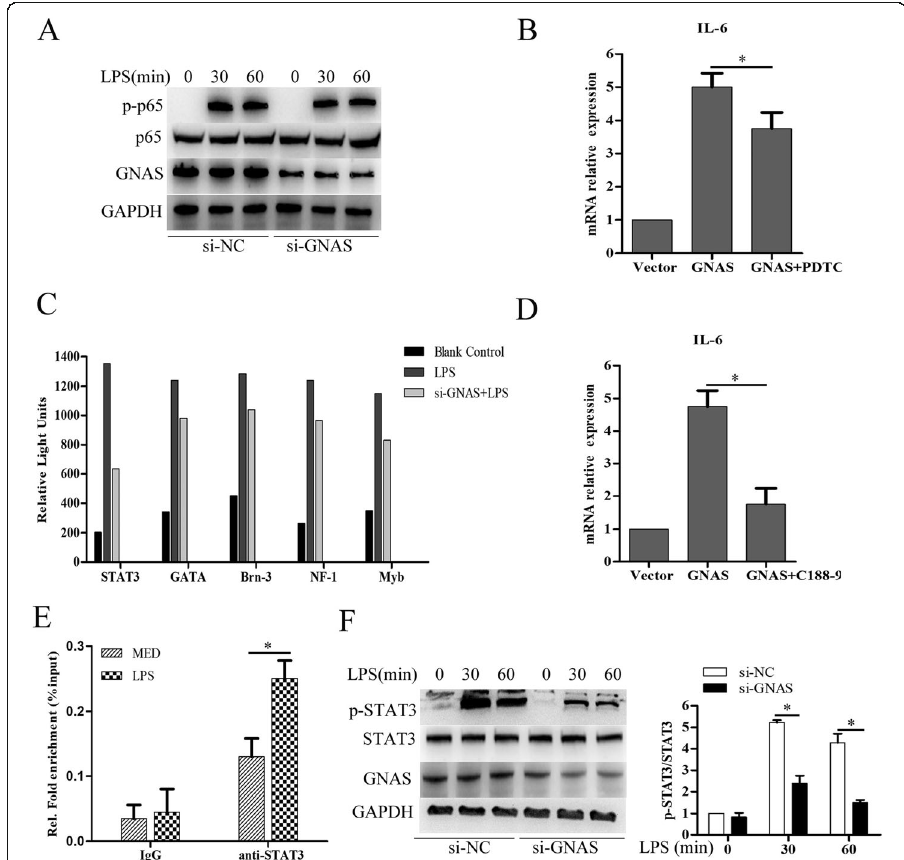
Fig. 3 GNAS knockdown inhibits LPS-induced IL-6 expression by suppressing STAT3 activation in HCC cells. a HepG2 cells were transfected with si-NC or si-GNAS for 24 h and then treated with LPS (5 μ g/ml) or not for the indicated hours. Then, the protein expression levels of p65, phosphorylated p65 (p-p65), and GNAS were detected by Western blotting. b HepG2 cells were transfected with pCMV-myc vector or pCMV-myc- GNAS for 24 h, and then treated with the specific inhibitor of NF-kB, PDTC, for 30 min. IL-6 mRNA expression levels were detected by qRT-PCR. c HepG2 cells were transfected with si-NC or si-GNAS for 24 h and then treated with LPS or MED for 30 min. Transcription factors activation profiling plate array was performed. d HepG2 cells were transfected with pCMV-myc vector or pCMV-myc-GNAS for 24 h, and then treated with a specific inhibitor of STAT3, c188 – 9, for 30 min. IL-6 mRNA expression levels were detected by qRT-PCR. e HepG2 cells were transfected with si-NC or si-GNAS for 24 h and then treated with LPS or MED for 30 min. STAT3 binding on IL-6 promoter was detected by ChIP assay. f HepG2 cells were transfected with si-NC or si-GNAS for 24 h and then treated with LPS (5 μ g/ml) or not for the indicated hours. Then, the protein expression levels of STAT3, phosphorylated STAT3 (p-STAT3), and GNAS were detected by Western blotting. Data are represented as means ± SD ( n = 3; * represents P <